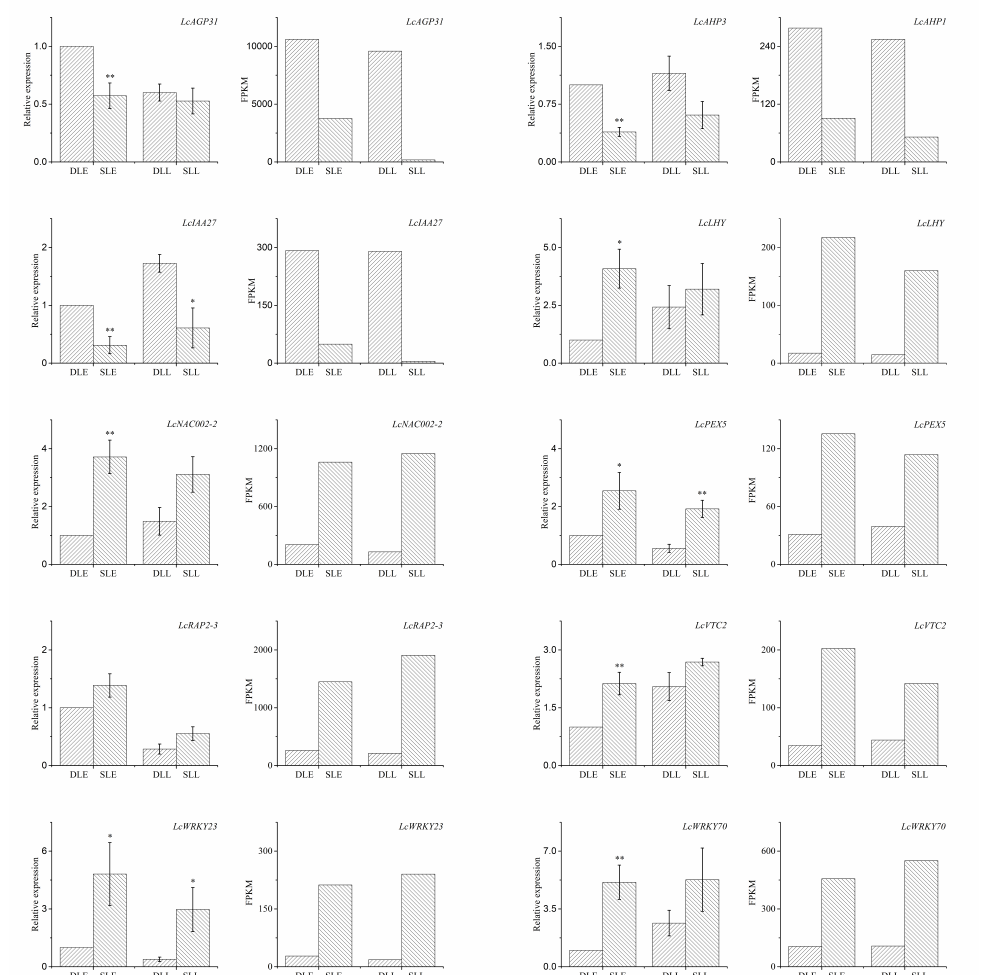
Figure 9. Expression of the 10 candidate differentially expressed genes determined by quantitative real-time PCR (qRT-PCR) and RNA-sequencing (RNA-Seq). Single asterisk indicates significant difference between developing leaves and senescing leaves at 0.05 probability level. Double asterisks indicate significant difference between developing leaves and senescing leaves at 0.01 probability